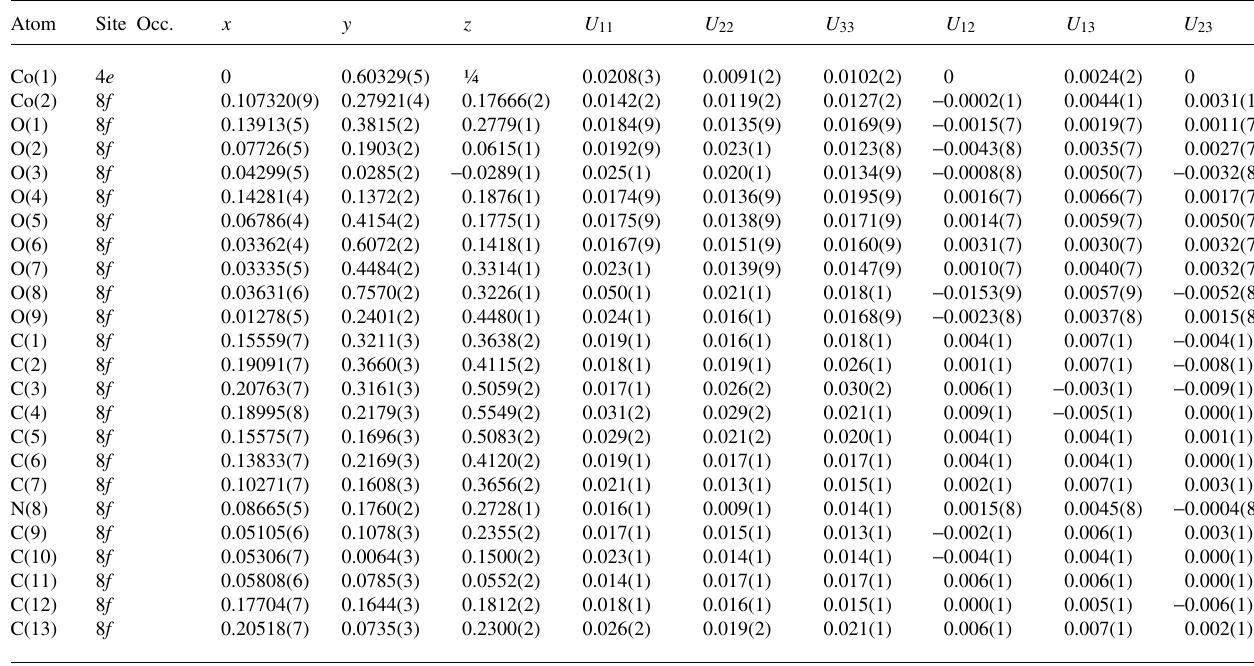
Table 3. Atomic coordinates and displacement parameters (in Å 2 ) .